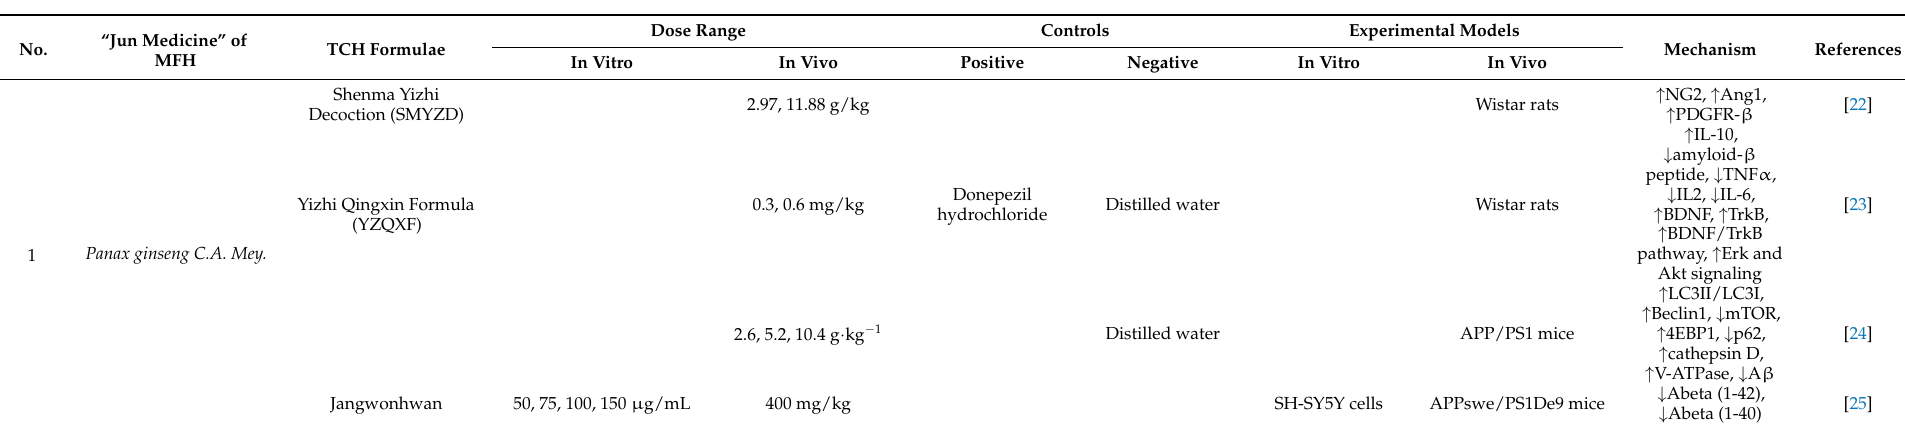
Table 3. The mechanism of “Jun medicine” of MFH in TCM formulae against Alzheimer’s